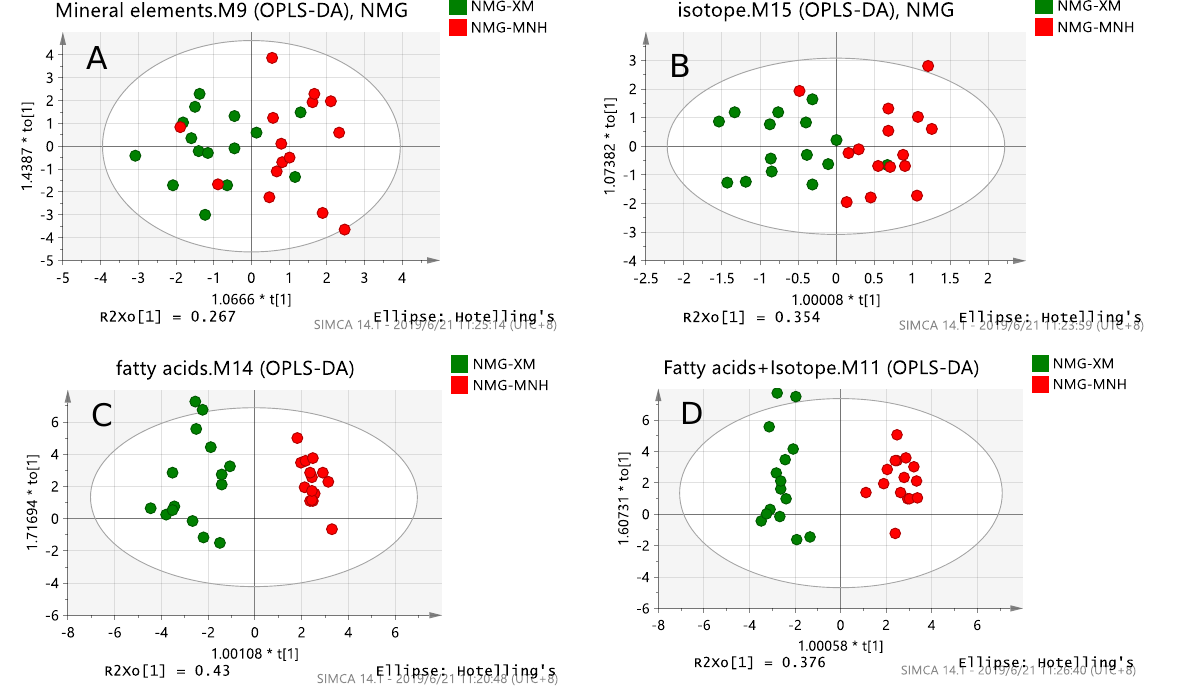
Figure 3. OPLS-DA score plots of Inner Mongolia samples obtained by a chemical analysis of: ( A ) Mineral elements; ( B )